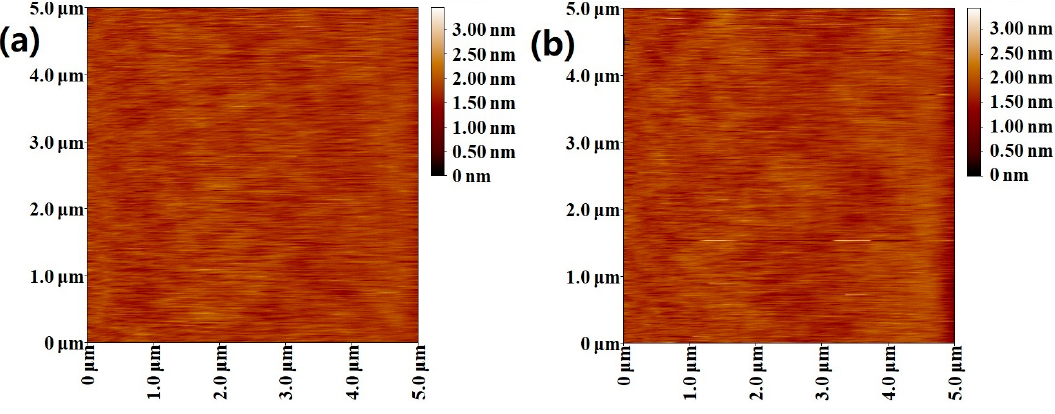
Figure 11. Atomic force microscopy (AFM) diagrams of ZrO 2 films. ( a ) 0.3 M precursor spin-coating 6 times. ( b ) 0.6 M precursor spin-coating 3 times.